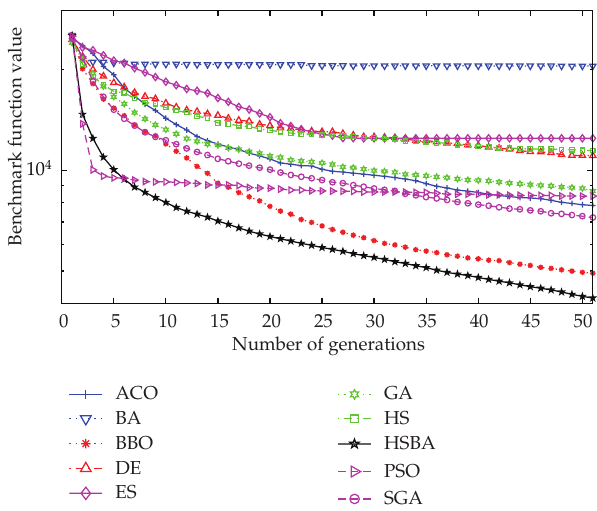
Figure 10: Comparison of the performance of the different methods for the F10 Schwefel 1.2